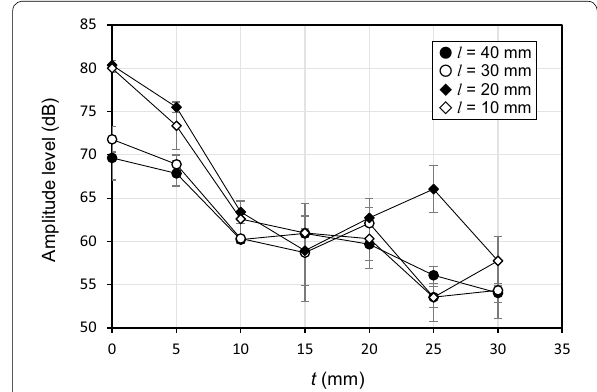
Fig. 8 Relationship between propagating distance ( t ) in the T direction and amplitude level of elastic waves for when the length ( l ) of the bamboo specimen was 40, 30, 20, and 10 mm. Error bars standard deviation (